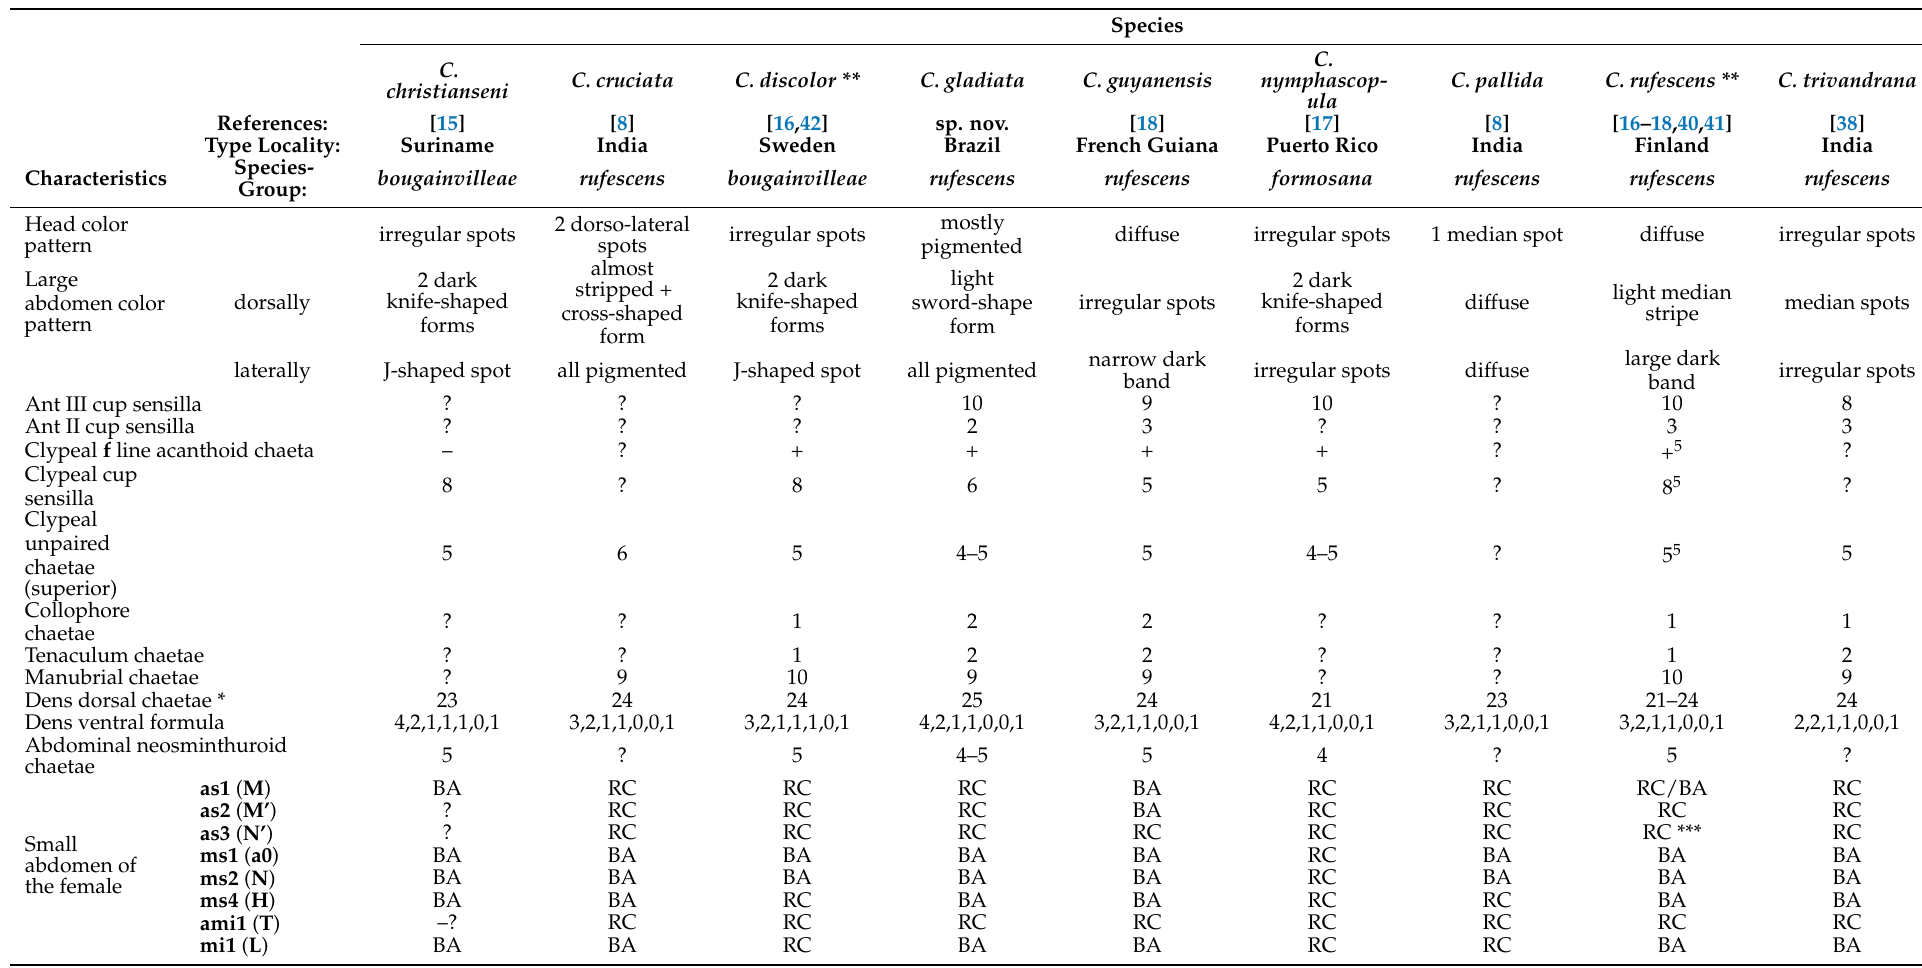
Table 2. Comparison among Calvatomina species from Neotropical Region plus species of the rufescens -group with the small abdomen of the female with as1 ( M ), as2 ( M’ ), as3 ( N’ ) and ami1 ( T ) as small regular pointed